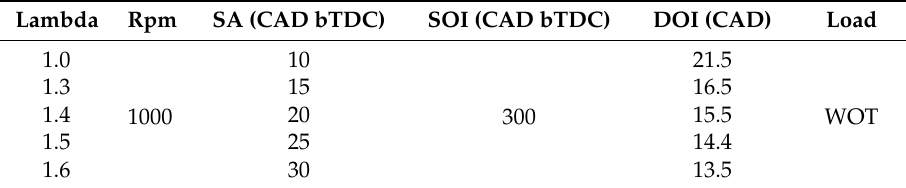
Table 2. Operating